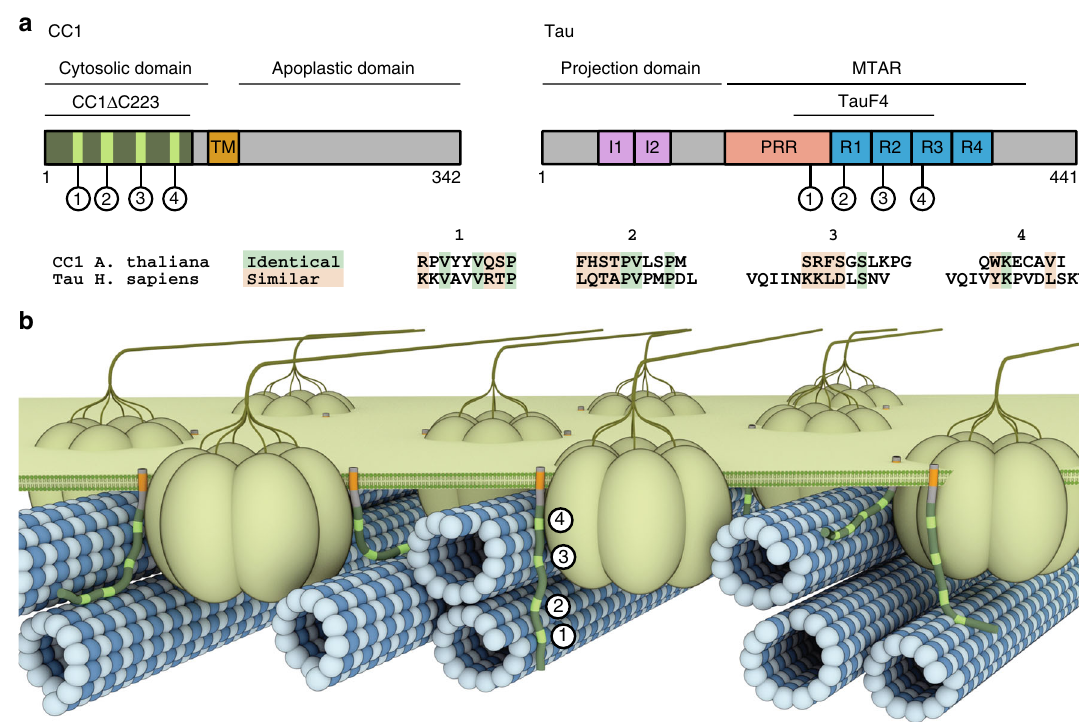
Fig. 6 Cartoon overview of the CC1-microtubule interaction and its similarity to Tau despite sequential differences. a Cartoon representation of the CC1 and hTau40 domain architecture. CC1 is composed of a cytosolic N-Terminus, transmembrane domain (TM) and an apoplastic C-terminal domain. hTau40 represents the longest isoform in humans containing two N-terminal inserts (I1, I2) in the projection domain, a polyproline region (PRR) and four imperfect repeats (R1 – R4) in the microtubule assembly region (MTAR). The position of the four respective microtubule-binding regions are marked and highlighted green in CC1. The amino acid sequences below compare the NMR-derived microtubule-binding regions of CC1 and Tau. Identical (green) and similar (orange; score of ≥ 0 in the BLOSUM62 matrix) amino acids are highlighted. b CC1 localization in its cellular context as part of the cellulose synthase complex (CSC). While the CSCs migrate along cortical microtubules during cellulose production, CC1 is involved in microtubule array organization via its cytosolic N-terminus. Similar to the Tau binding behavior, the CC1-microtubule interaction is dynamic and the microtubule-binding motifs (green) are potentially able to bind several tubulin dimers, distributed over one or several microtubules, thereby affecting microtubule bundling or dynamics. The individual components of the cartoon representation are drawn to scale, except for CC1 thickness and omission of its apoplastic domain. Membrane association and length of CC1, as well as the microtubule diameter, determine possible interaction